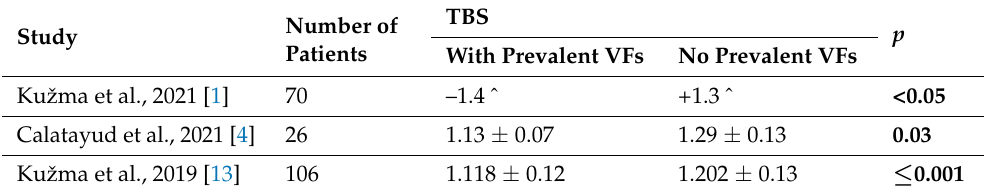
Table 5. Correlations reported between trabecular bone score and vertebral fractures